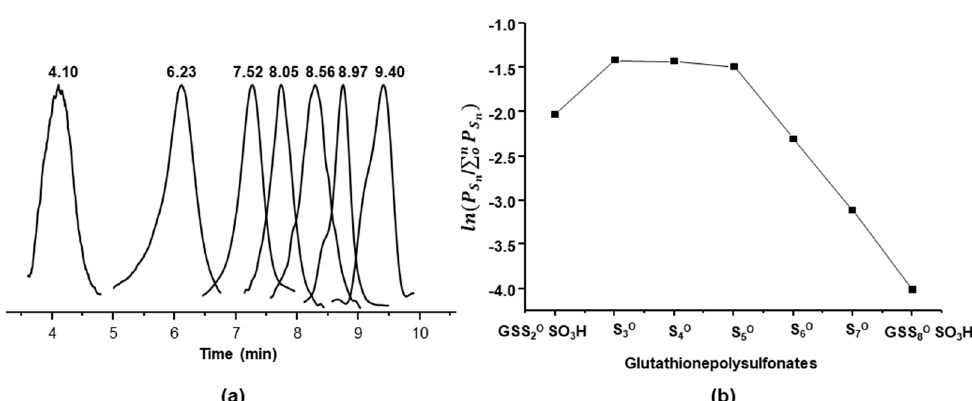
Figure 4. Normalized SIC ( a ) mass spectra of oxidized glutathione polythiosulfonates, GSS n SO 3 H, generated in the aerobic reaction of GSNO (1 mM) with Na 2 S (1 mM) in IP buffer at pH 7 and ( b ) relative distribution as calculated from the peak area of the SICs.